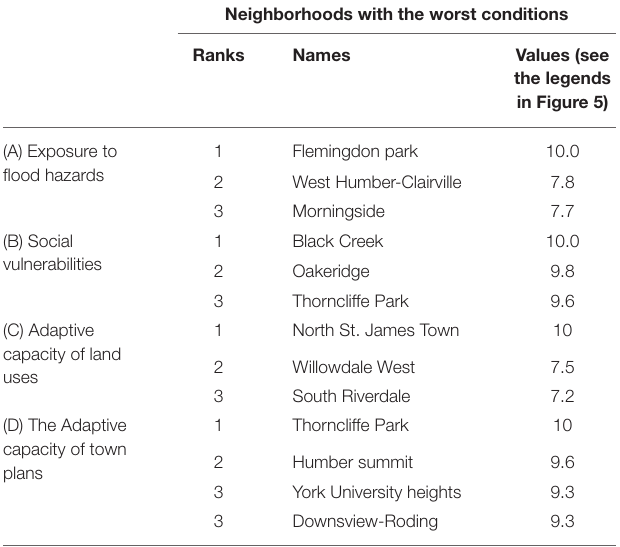
TABLE 4 | The list of neighborhoods with the worst conditions in terms of each risk driver. Neighborhoods with the worst conditions Ranks Names